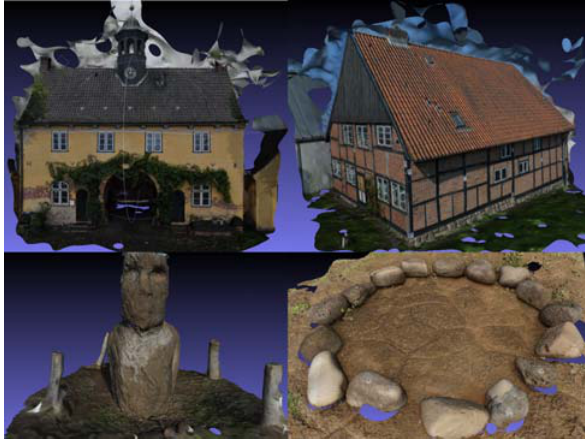
Figure 3. Textured 3D surface models – facade of the gatehouse in Jersbek (top left), part of the oldest town house in Bad Segeberg (top right), Moai Vaihu (bottom left) and a turtle as a petroglyph on Easter Island (bottom